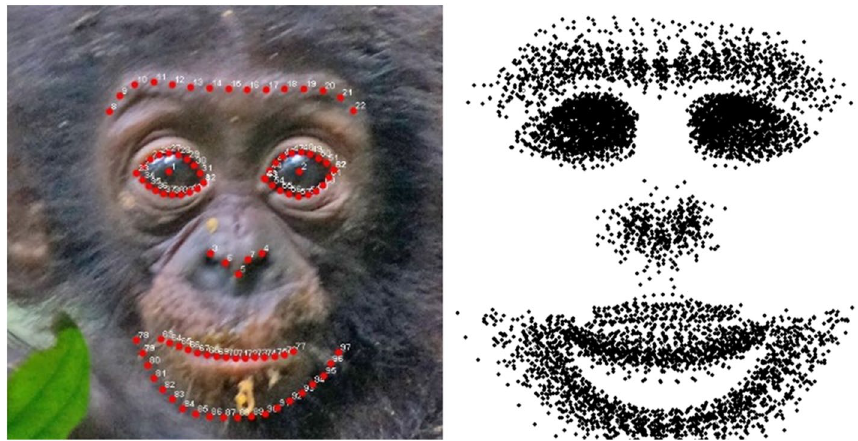
Figure 1. An example of landmark delineation on an infant bonobo face (left) and the superposition of all landmarks of 80 faces after the Procrustes fit for visualization of the whole variation